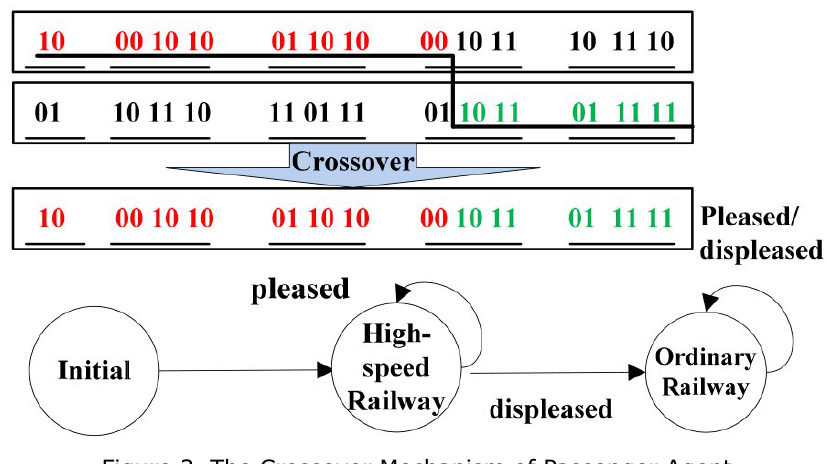
Figure 3. The Crossover Mechanism of Passenger Agent